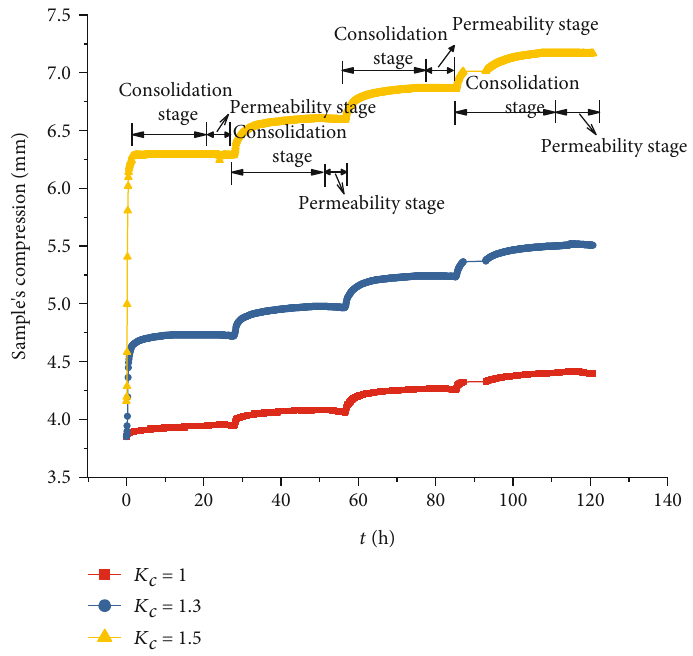
Figure 9: The curve of normally consolidation clay compression with time at di ff erent consolidation stress